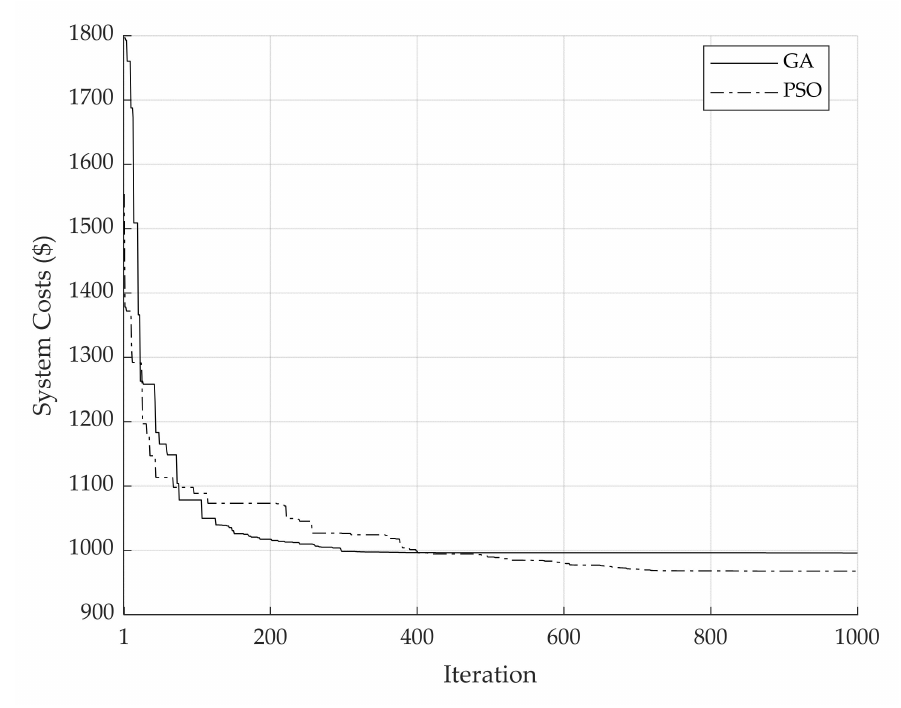
Figure 6. The comparison results between GA and